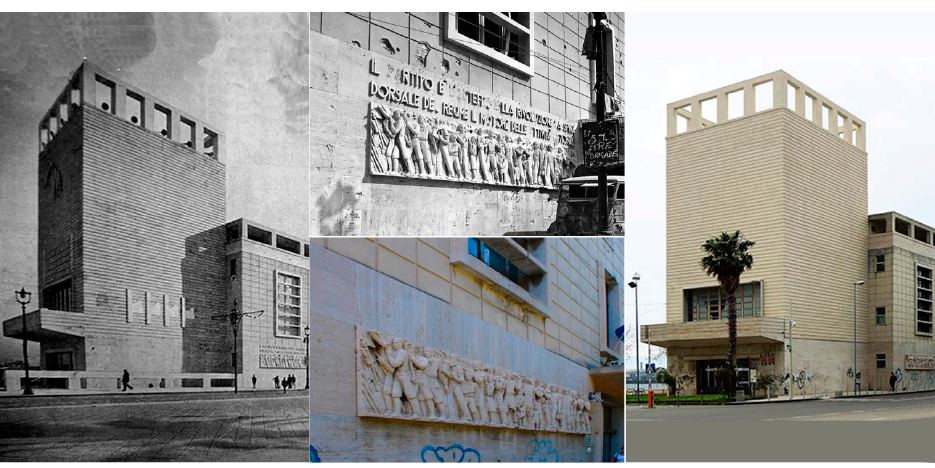
Figure 12. The transformations of the 1970s: one of two mixtilinear stairs is demolished to make way for an elevator.